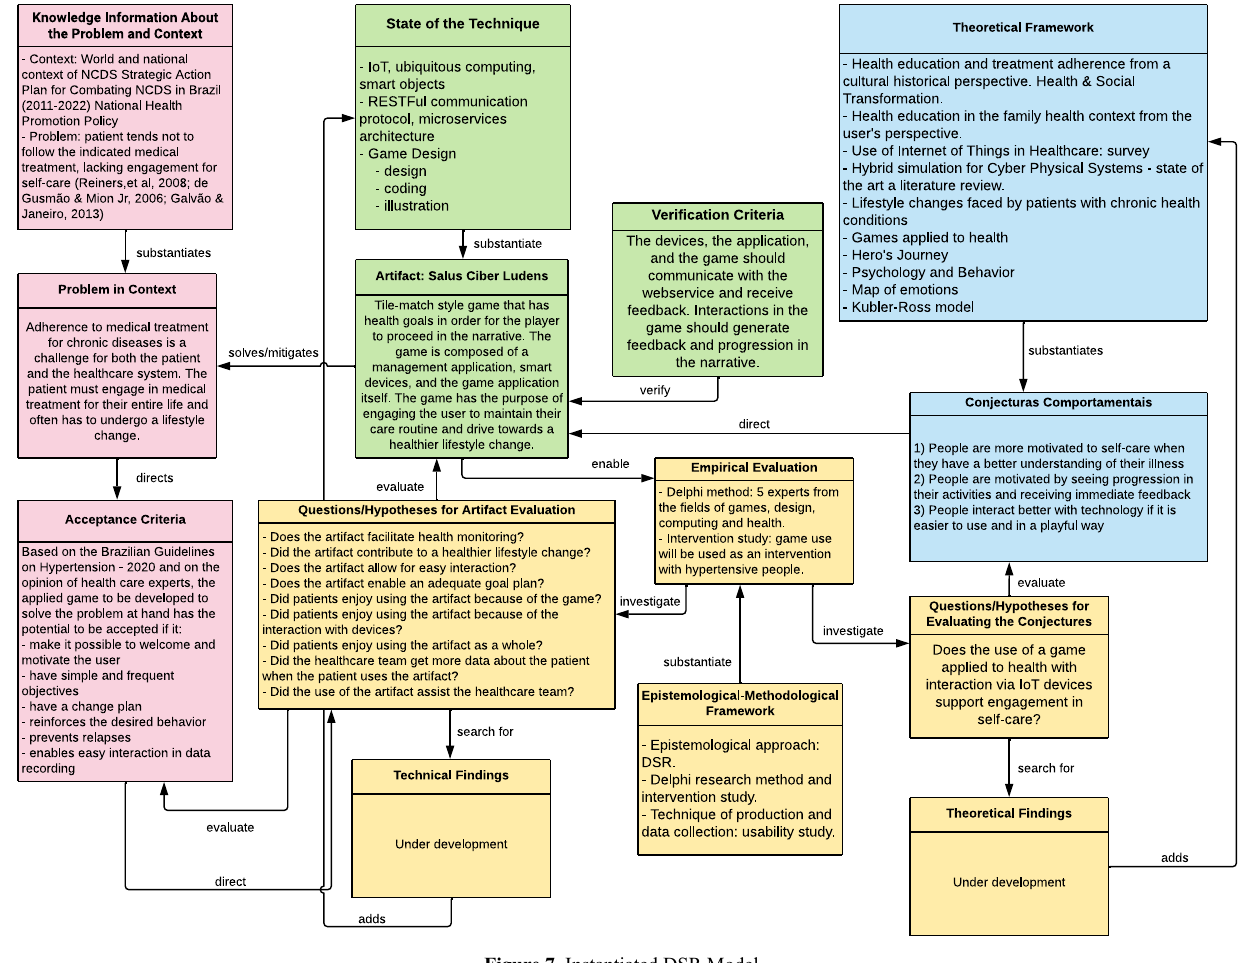
Figure 7. Instantiated DSR Model.